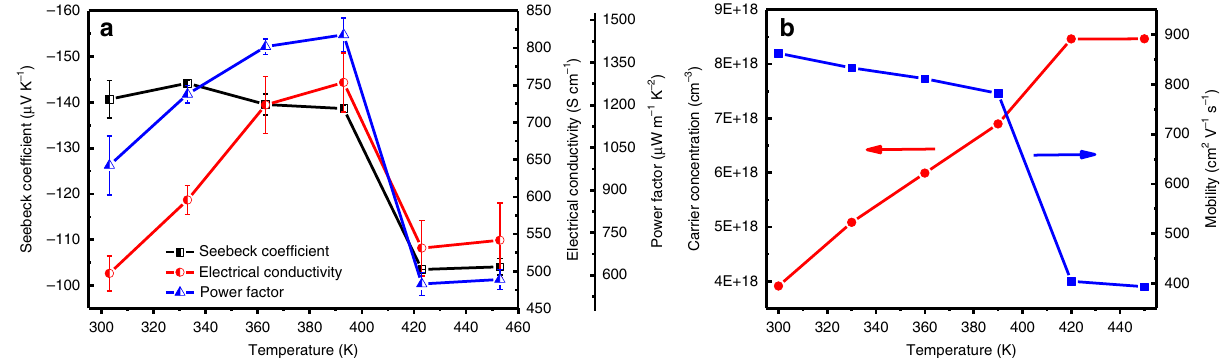
Fig. 2 In-plane TE properties of the fi lm. a Temperature dependence of Seebeck coef fi cient, electrical conductivity and power factor for the Ag 2 Se fi lm (Each point shows the standard deviations from two independent measurements). b Temperature dependence of carrier concentration and mobility for the Ag 2 Se fi lm